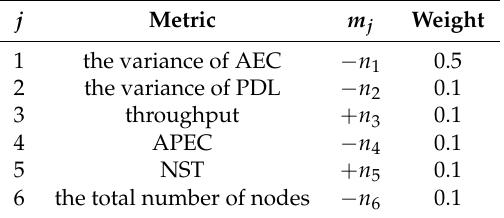
Table 3. Metrics with corresponding parameters.